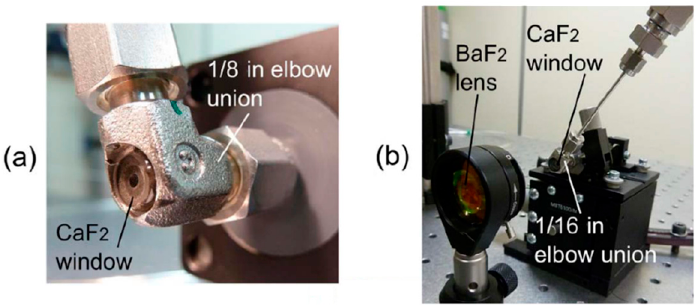
Figure 6. Photographs of the gas fitting ports used in [24]. Reprinted with permission from [24], © The Optical Society.